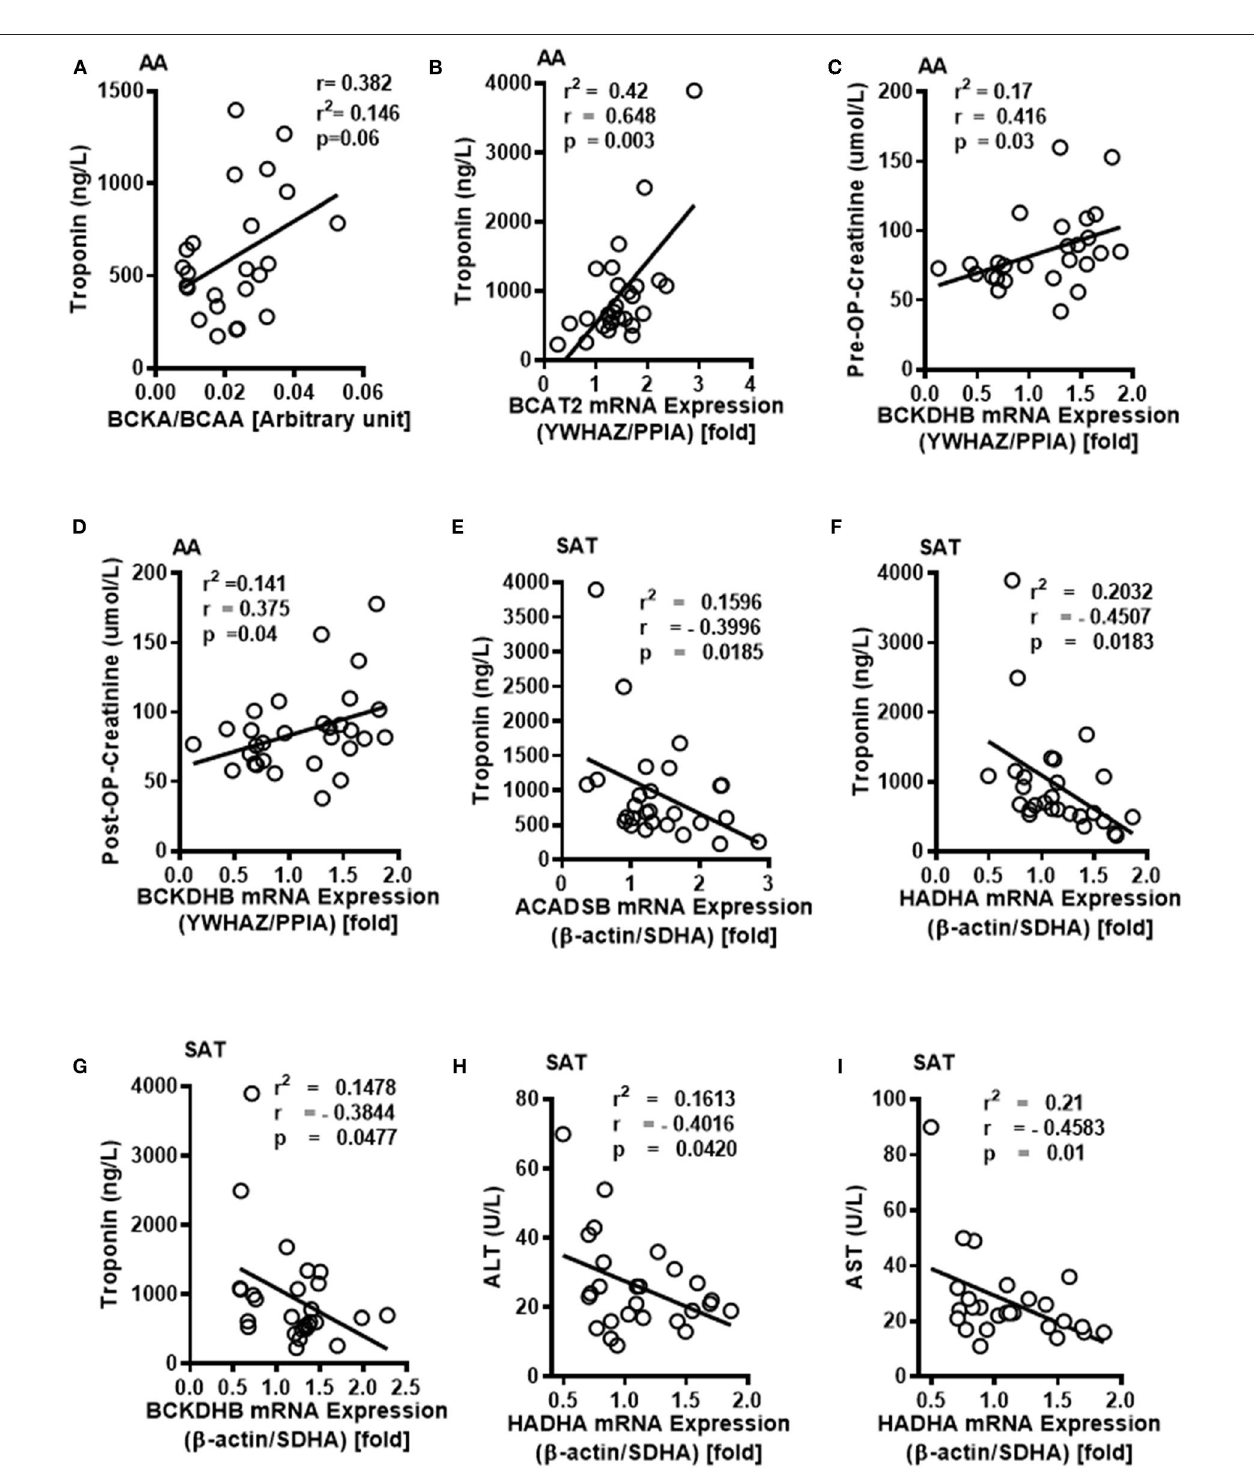
FIGURE 6 | Intramyocellular BCAAs and altered BCAA catabolic enzyme expressions in the SAT and AA tissues are associated with markers of tissue dysfunction in cardiac surgery patients with increasing obesity. (A) Linear regression of BCKA to BCAA levels in the AA tissues of non-obese ( n = 5), pre-obese ( n = 5), class I obese ( n = 5), class II obese ( n = 5) and class III obese ( n = 5) cardiac surgery patients correlated with pre- operative plasma troponin levels. In the AA tissues of non-obese ( n = 6), pre-obese ( n = 6), class I obese ( n = 6), class II obese ( n = 6) and class III obese ( n = 6) patients undergoing cardiac surgery, linear regression of (B) BCAT2 mRNA expression were correlated with post-operative plasma troponin levels, (C,D) Linear regression of BCKDHB mRNA levels were correlated with pre and